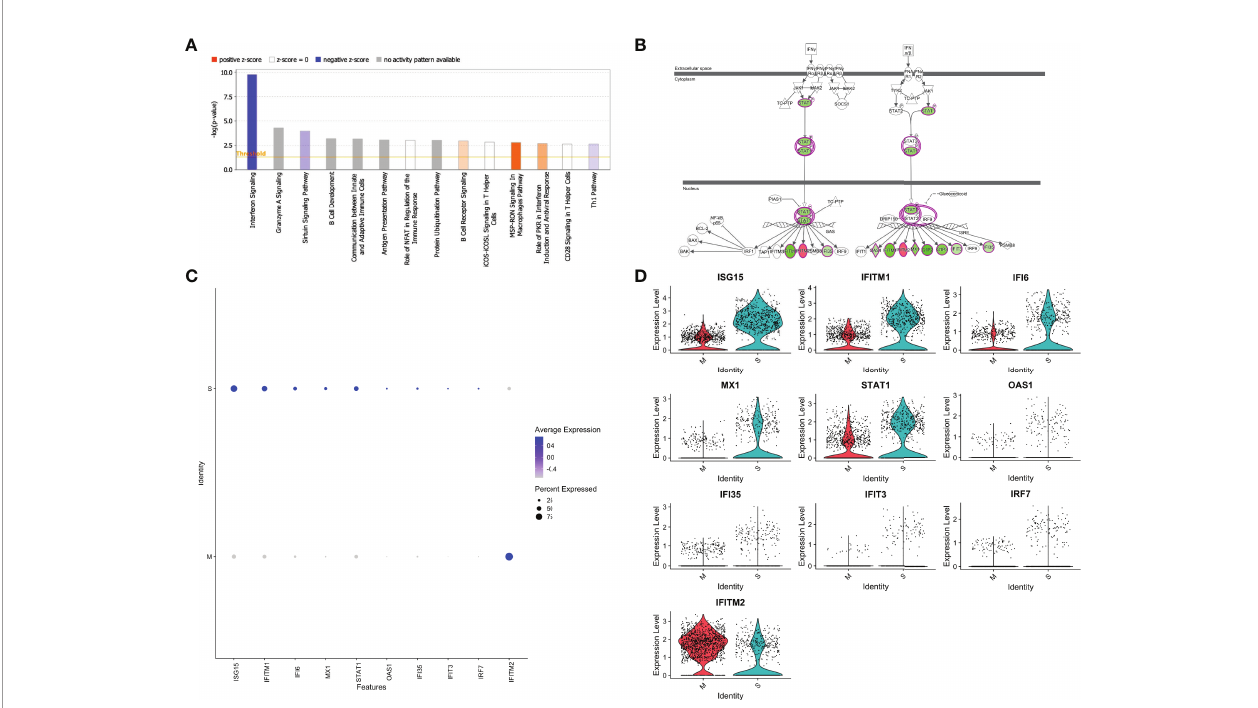
FIGURE 4 | SARS-CoV-2 membrane (M) protein downregulates types I, II, III interferon pathway signaling in CD4+ T cell lines generated from unexposed individuals. Canonical signaling pathways of immunological relevance affected in M protein-speci fi c TCLs (A) indicating a marked suppression interferon signaling pathway and others, including Th1 pathway. (B) Map of the interferon signaling pathway indicating the 9 downstream molecules that were associated with the suppression of interferon, where in green are the genes affected negatively or in red the genes upregulated by SARS-CoV-2 M protein. Feature graph (C) and the violin plot graph (D) showing the average expression and the percent expression of the interferon signaling pathway genes in the respective S-protein-speci fi c CD4 + T cell lines and M-protein-speci fi c CD4 + T cell lines. Figures 4A and 4B were generated by QIAGEN Ingenuity Pathway Analysis patients with a functionally impaired CD4 + T cell response showing reduced production of IFN- g and TNF- a (26).